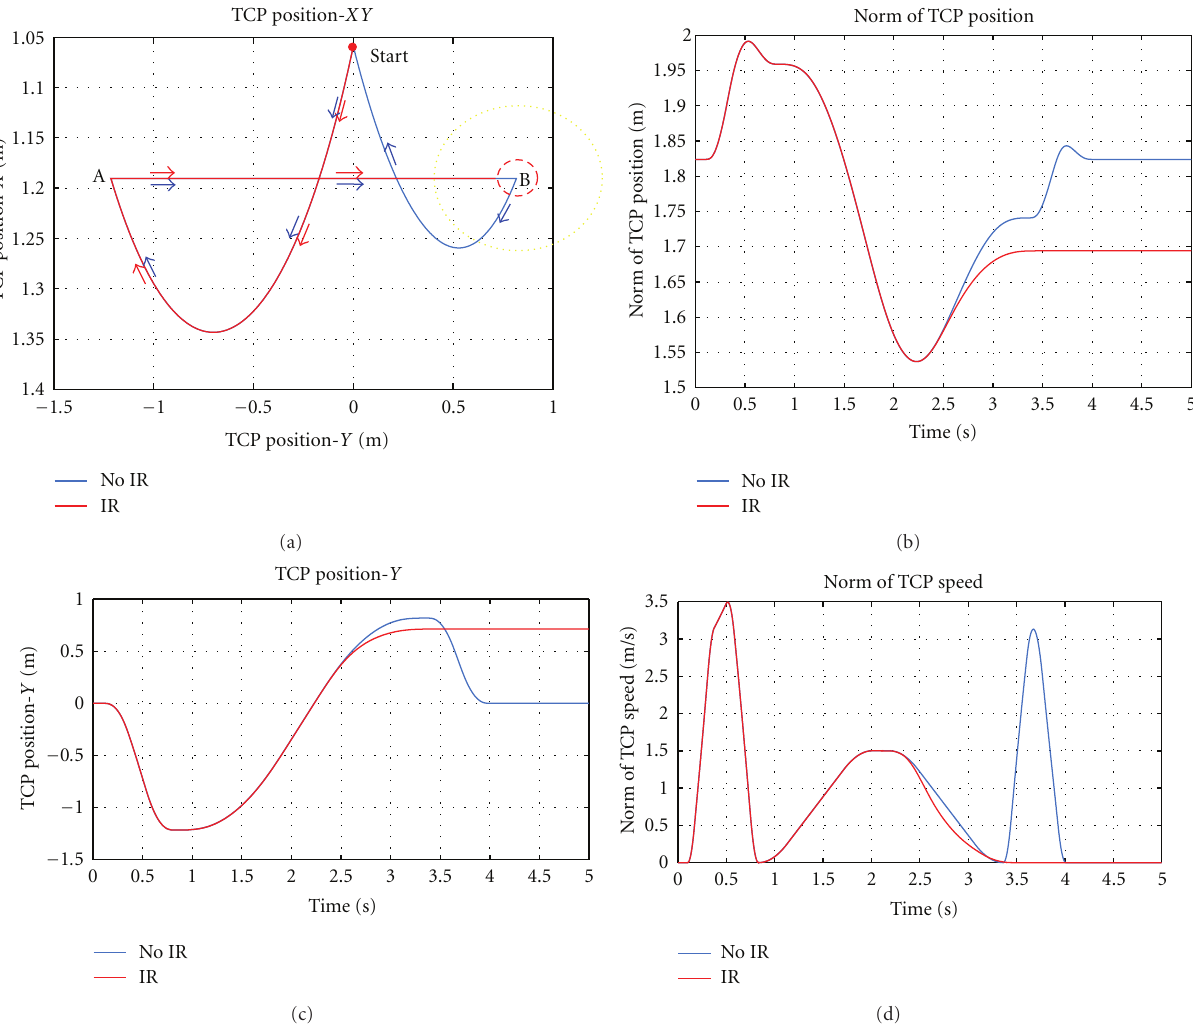
Figure 12: (a) Robot position ( X , Y ), with enabled/disabled control, (b) norm of the end-e ff ector position over time, (c) trend of the Y end-e ff ector position over time, and (d) norm of the robot speed over